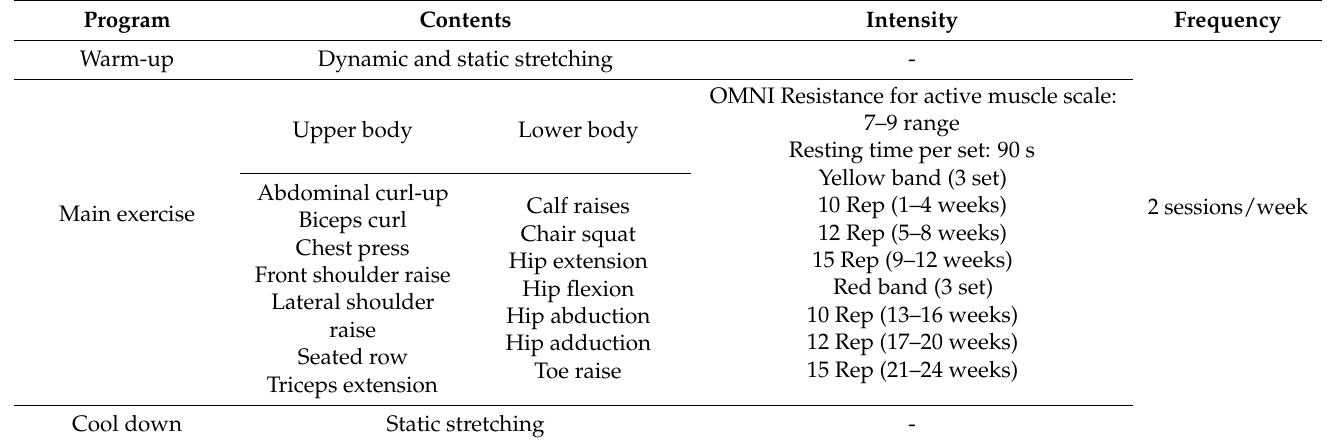
Table 2. Twenty-four-week resistance exercise training program for the